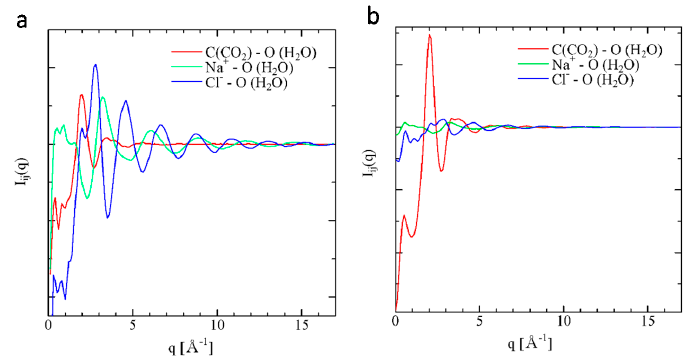
Figure 3. ( a ) I ij ( r ) at 283 K, 0.5 MP and ( b ) I ij ( r ) at 275 K, 100 MP.